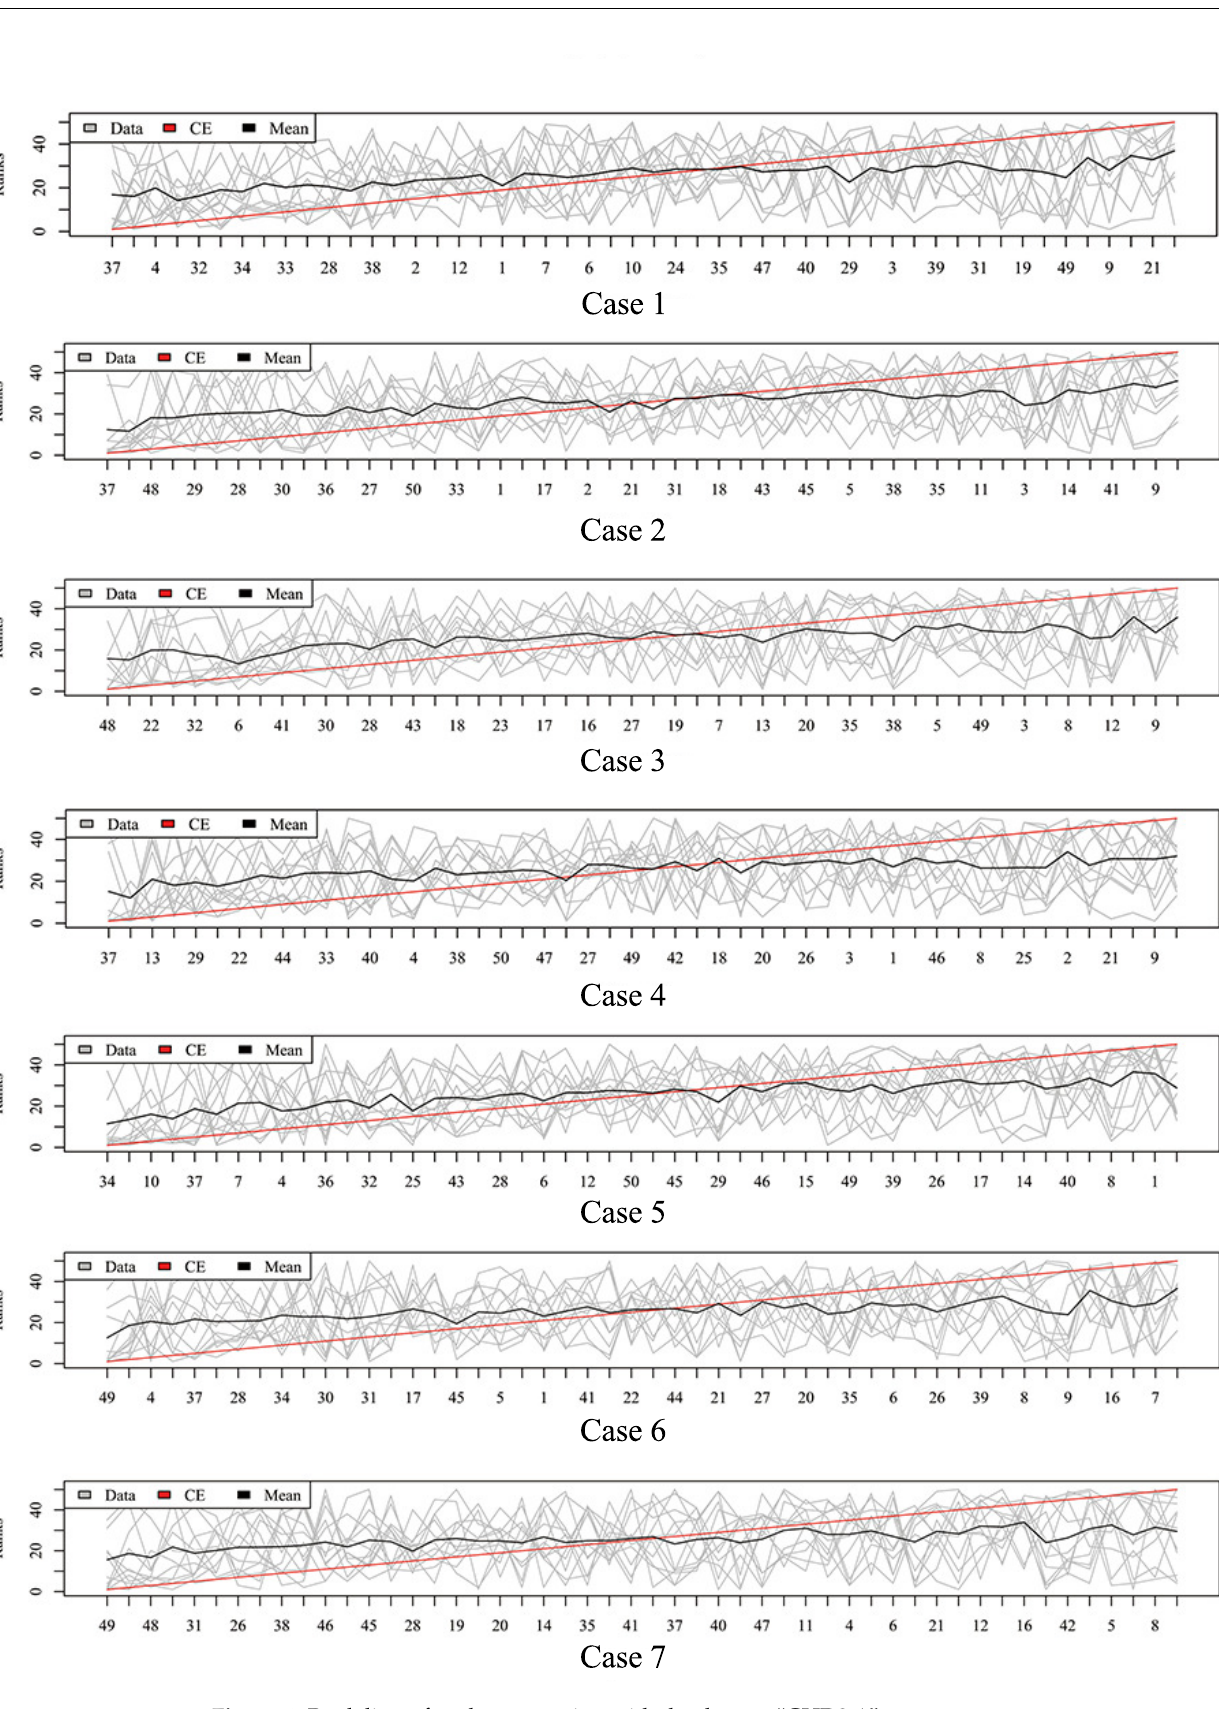
Figure 4. Rank lists of rank aggregation with the dataset “CHD2-1” on seven